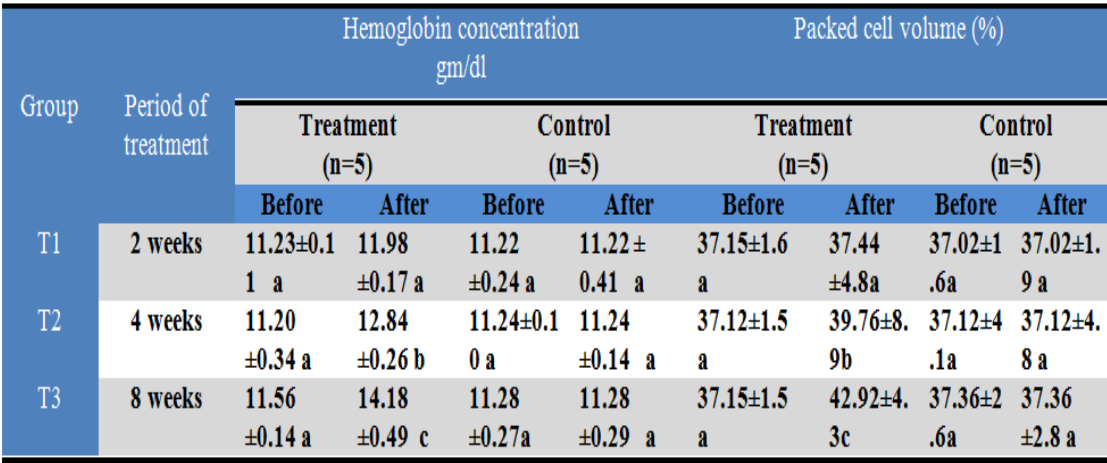
Values are expressed as means ± SE. Table 6: Effect of orally administering a low dose (4.8 mg/kg/day) of Citrullus colocynthis on hemoglobin concentration and packed cell volume of rabbits .